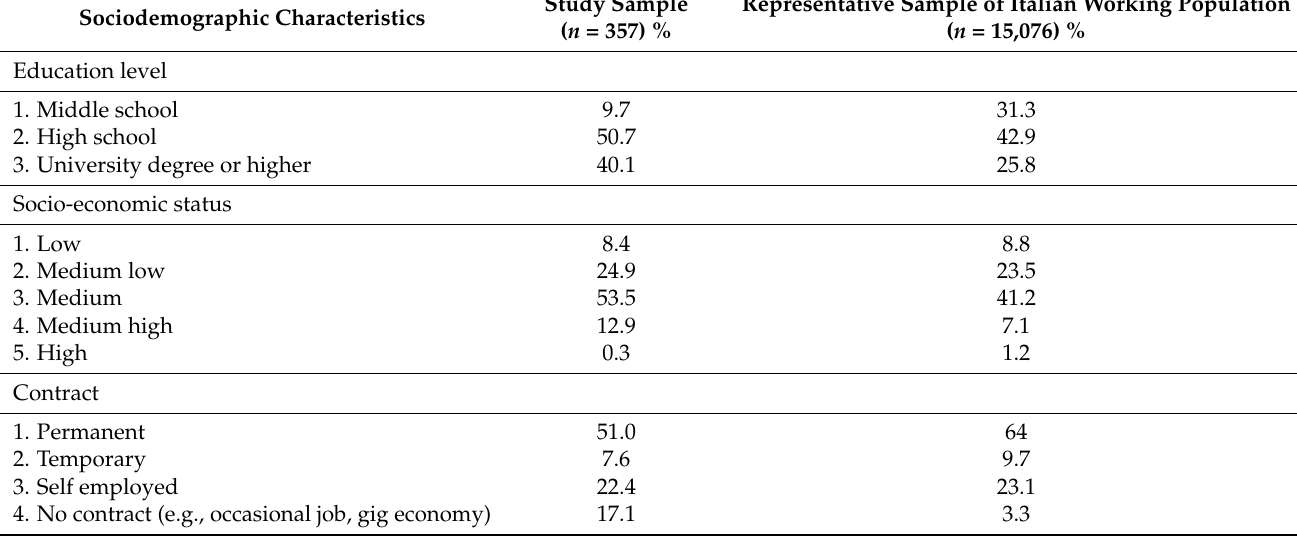
Table A1. Main sociodemographic features of the sample as compared with a representative sample of the Italian working population in